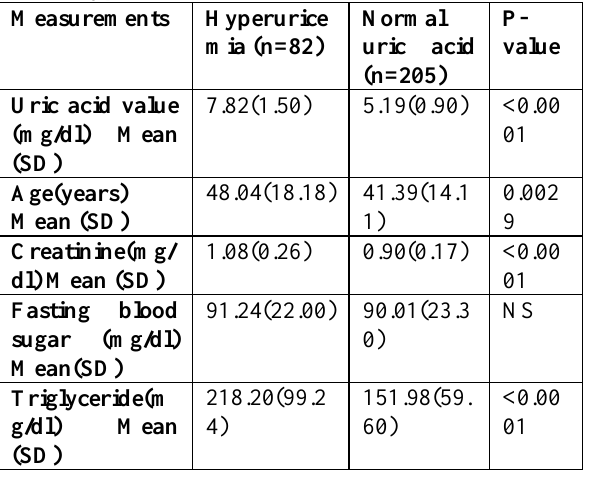
Table No. 4.5 Single Variable Analysis of Hyperuricemia and